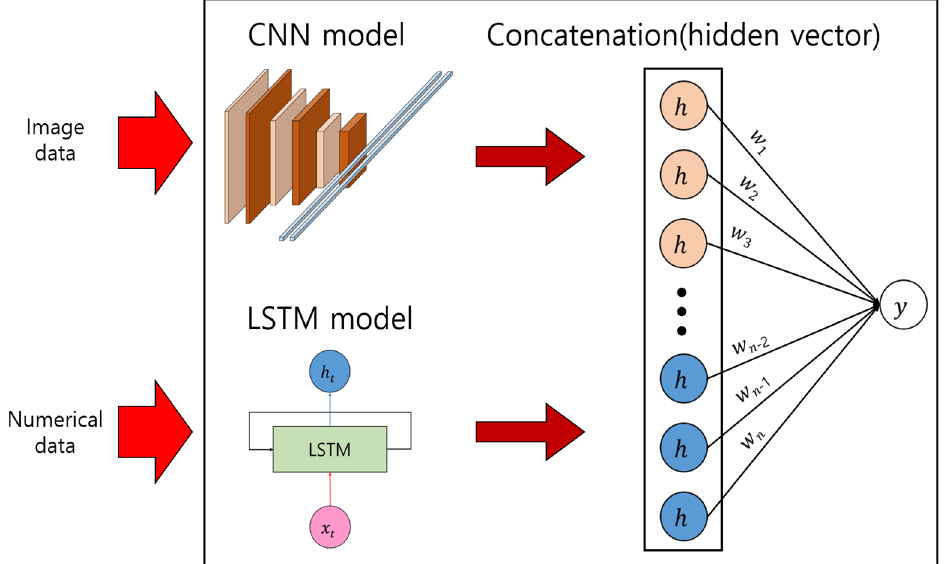
Figure 7. Integration between learned representations: It is a method of combining representations learned with different neural networks (CNN, LSTM). The representations learned through each neural network are connected to and combined with the hidden layer, and learning is performed in a way that finds the optimal weight connected to the hidden layer.